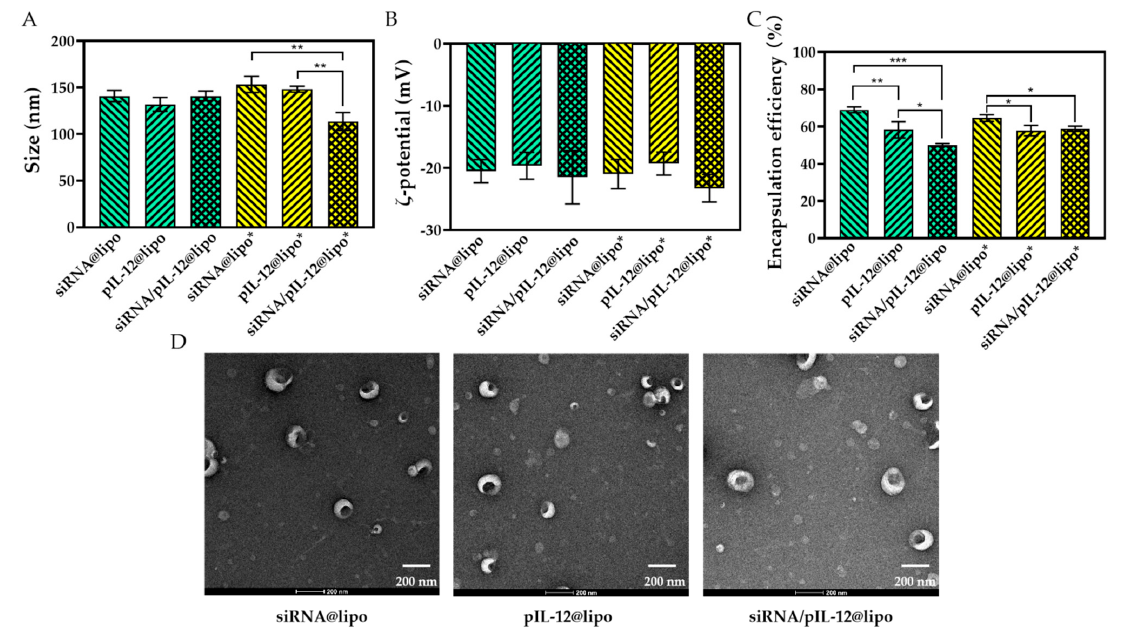
Figure 1. The size ( A ), ζ –potential ( B ), encapsulation efficiency ( C ), and TEM images ( D ) of different complexes (* p < 0.05, ** p < 0.01, *** p < 0.001; n = 3).